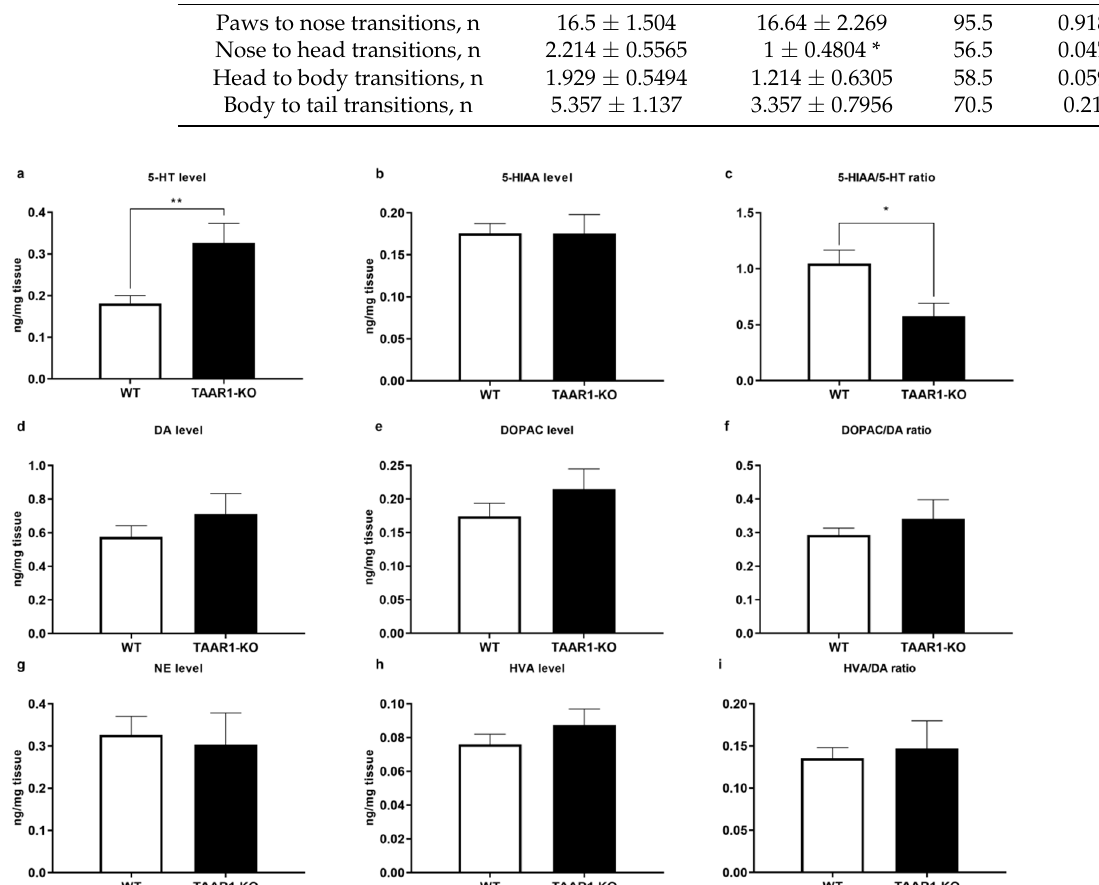
Figure 5. Altered 5-HT neurotransmission in the TAAR1 knockout (KO) mouse cortex. Panels show cortical levels of 5-HT, 5-HIAA and turnover, assessed by the 5-HIAA/5-HT ratio ( a – c ), tissue level of dopamine (DA), 3,4-dihydroxyphenylacetic acid (DOPAC) and turnover, assessed by the DOPAC/DA ratio ( d – f ), and tissue level of NE, homovanillic acid (HVA) and turnover, assessed by the HVA/DA ratio, in the WT and TAAR1-KO mice ( g – i ). Cortical 5-HT level was higher in TAAR1-KO mice ( a ), who also had lower 5-HIAA/5-HT ratio ( c ). Data are presented as mean ± SEM (WT n = 18; TAAR1-KO n = 11). * p < 0.05, ** p < 0.05 vs. control, Mann–Whitney U-test. Extended data are presented in Supplementary Materials (Table